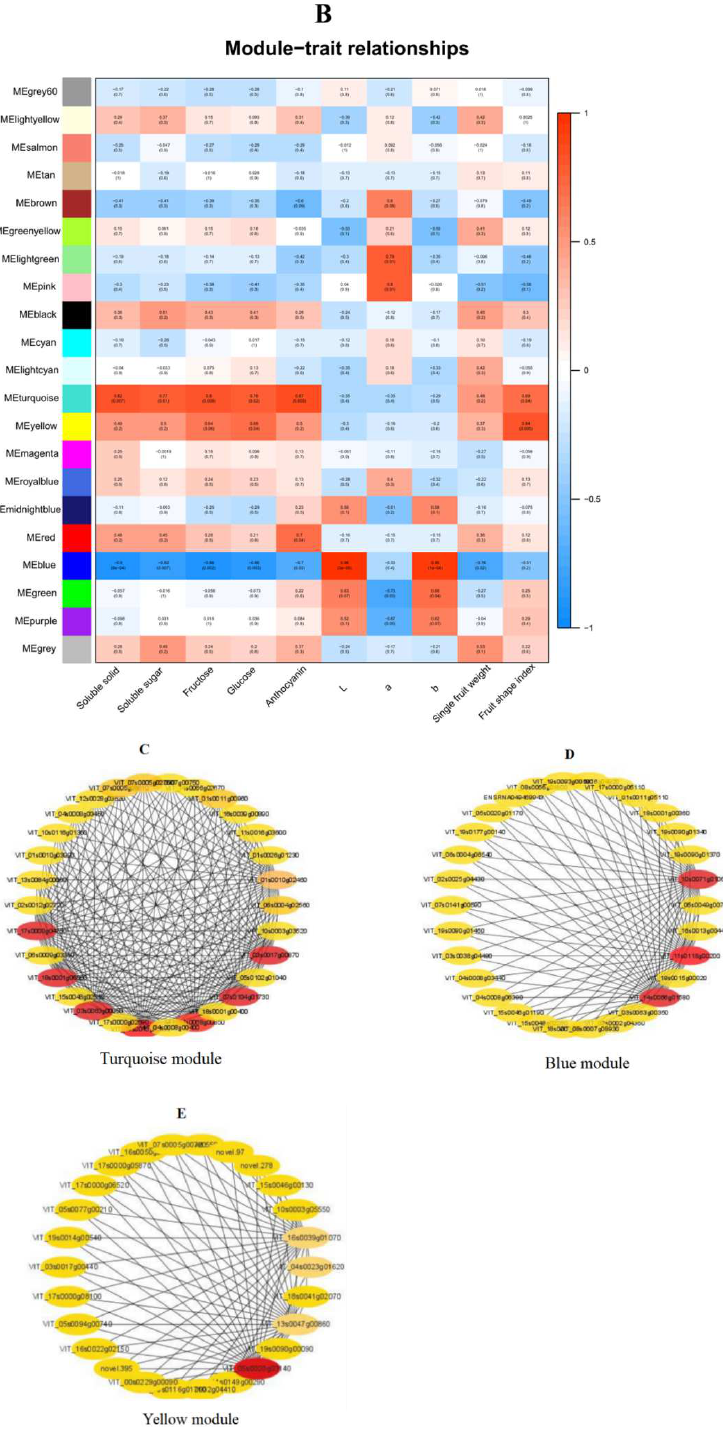
Figure 10. WGCNA identified gene networks and key candidate genes during grape fruit develop- ment. ( A ): Hierarchical clusters represent 21 distinct modules with co-expressed genes. Each leaflet in the tree represents an individual gene. ( B ): Pearson correlation-based module trait relationship. The color grids from blue to red represent the r 2 value ( − 1 to 1). ( C – E ): The red module gene network was significantly correlated with the content of sugar, anthocyanin, and potassium. Key candidates within each network are highlighted in deep red based on highest weight in their respective module and identified for gene descriptors based on annotation